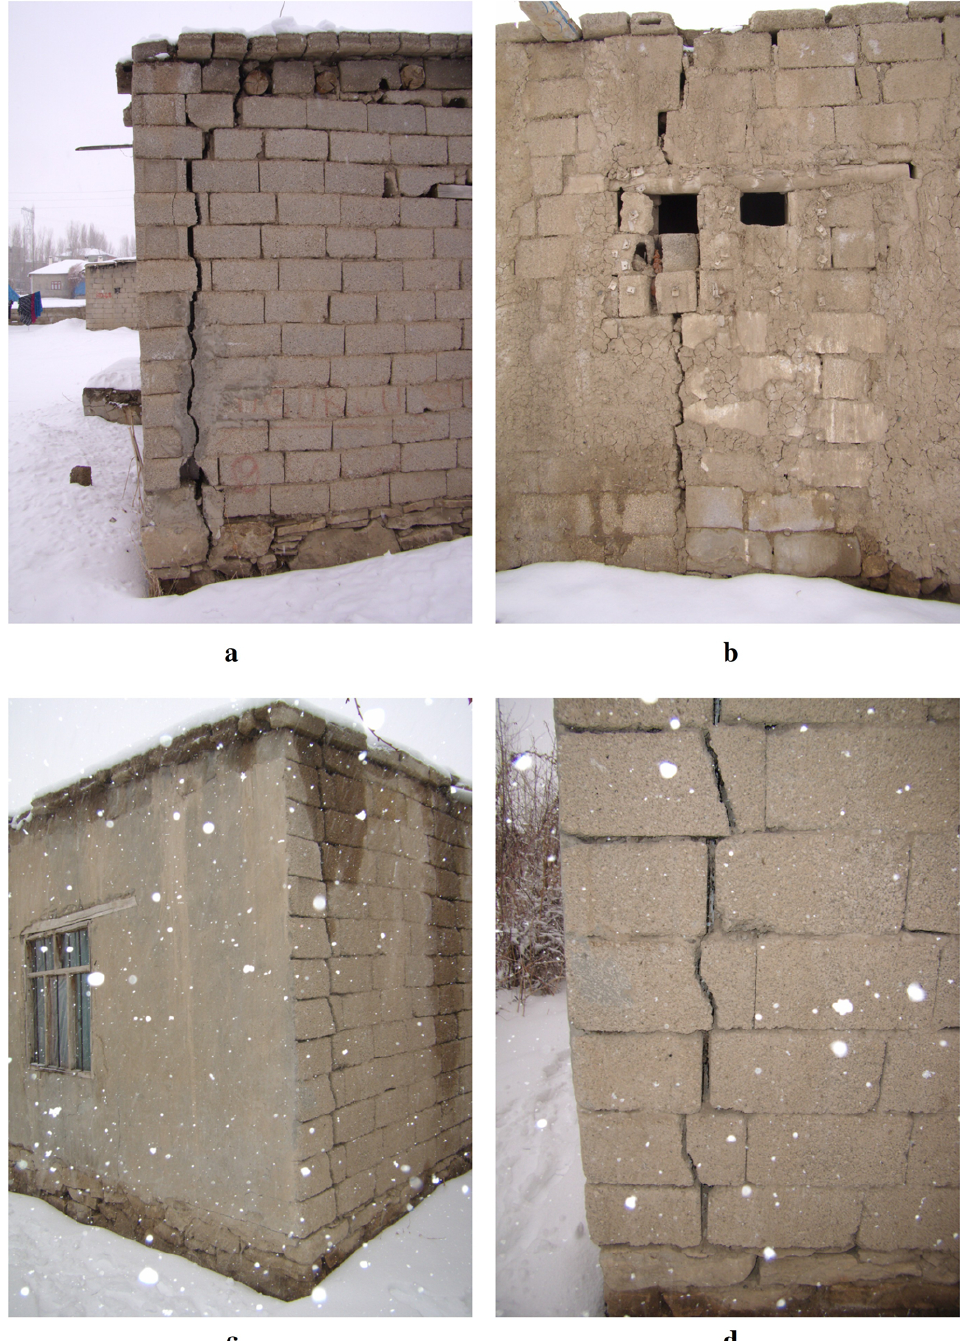
Fig. 15. Serious vertical crack propagations in the